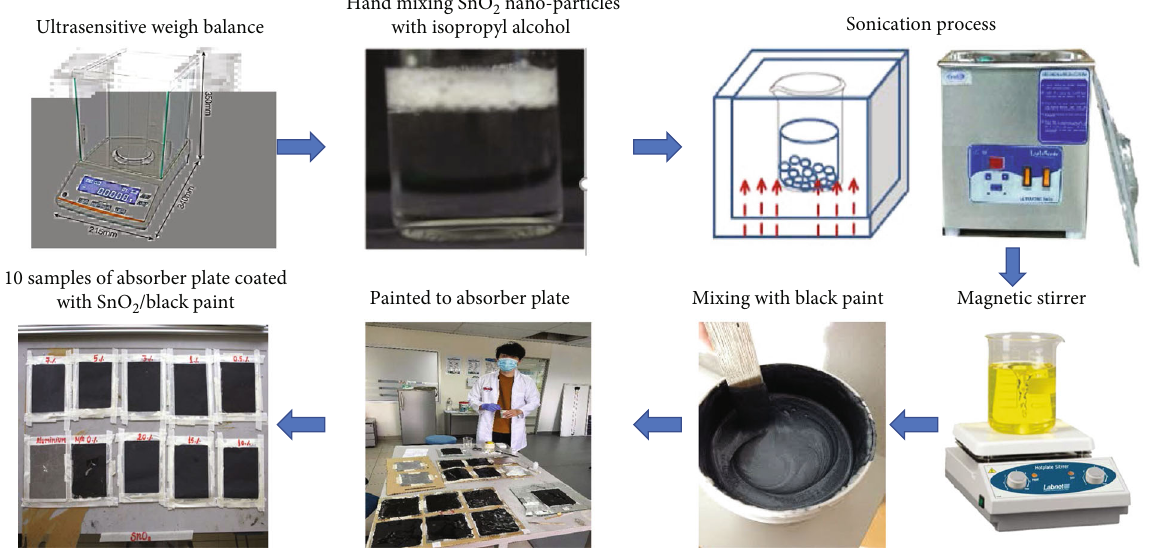
Figure 1: The process of impregnating SnO2 nanoparticles in absorber plates coated with black